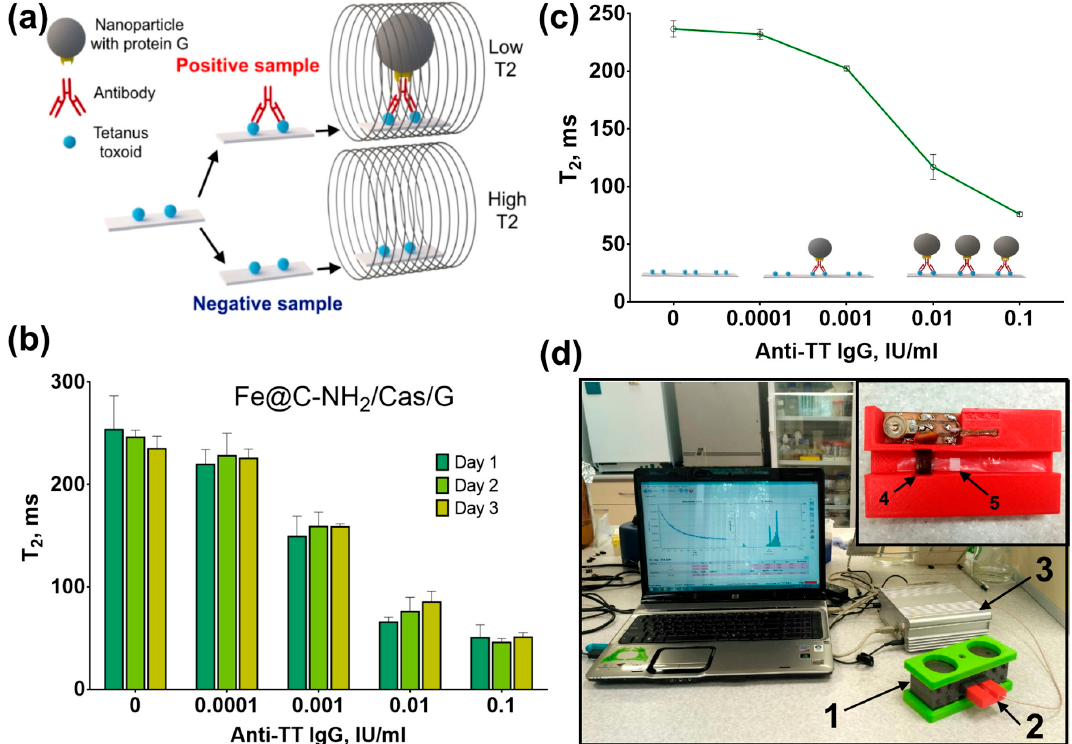
Figure 5. Application of protein-coated magnetic nanoclusters in nuclear magnetic resonance (NMR)-immunoassay of IgG against the anti-tetanus toxoid. ( a ) the principle of the assay; ( b ) day-to-day variability of the anti-TT NMR-assay; ( c ) dose-response curve obtained using Fe@C-NH 2 / Casein / G; ( d ) NMR-relaxometer and sample holder (inset): 1—magnet, 2—sample holder, 3—NMR-relaxometer, 4—radio-frequency coil, and 5—test-strip in plastic envelope.